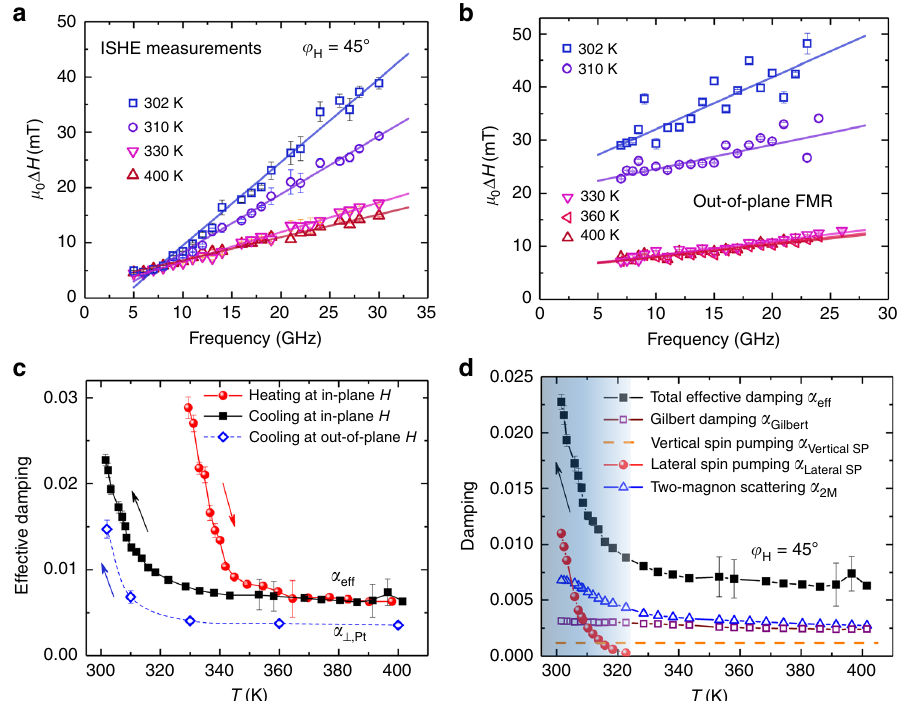
Fig. 6 Temperature dependence of damping during the phase transition. a , b f- dependence of μ 0 Δ H at four typical temperatures for FeRh (10)/Pt. The values of μ 0 Δ H are extracted from a in-plane spin pumping measurements at φ H = 45°, θ H = 90°; b out-of-plane FMR measurements at φ H = 45°, θ H = 0°. The error bars are standard deviations obtained from the fi t of the d.c. voltages and FMR spectra. c Effective damping at different T during heating and cooling. The solid spheres and squares are the data acquired from the spin pumping voltage measurements at φ H = 45°, θ H = 0°. The open rhombus represents the data acquired from out-of-plane ( φ H = 45°, θ H = 90°) fi lm-FMR measurements. d Four contributions to the total effective damping as a function of T : α eff ( T ) = α Gilbert ( T ) + α Vertical SP ( T ) + α Lateral SP ( T ) + α 2M ( T ). The blue shadow in d indicates the temperature region during the phase transition. The error bars of damping in c and d are obtained from the linear fi tting of